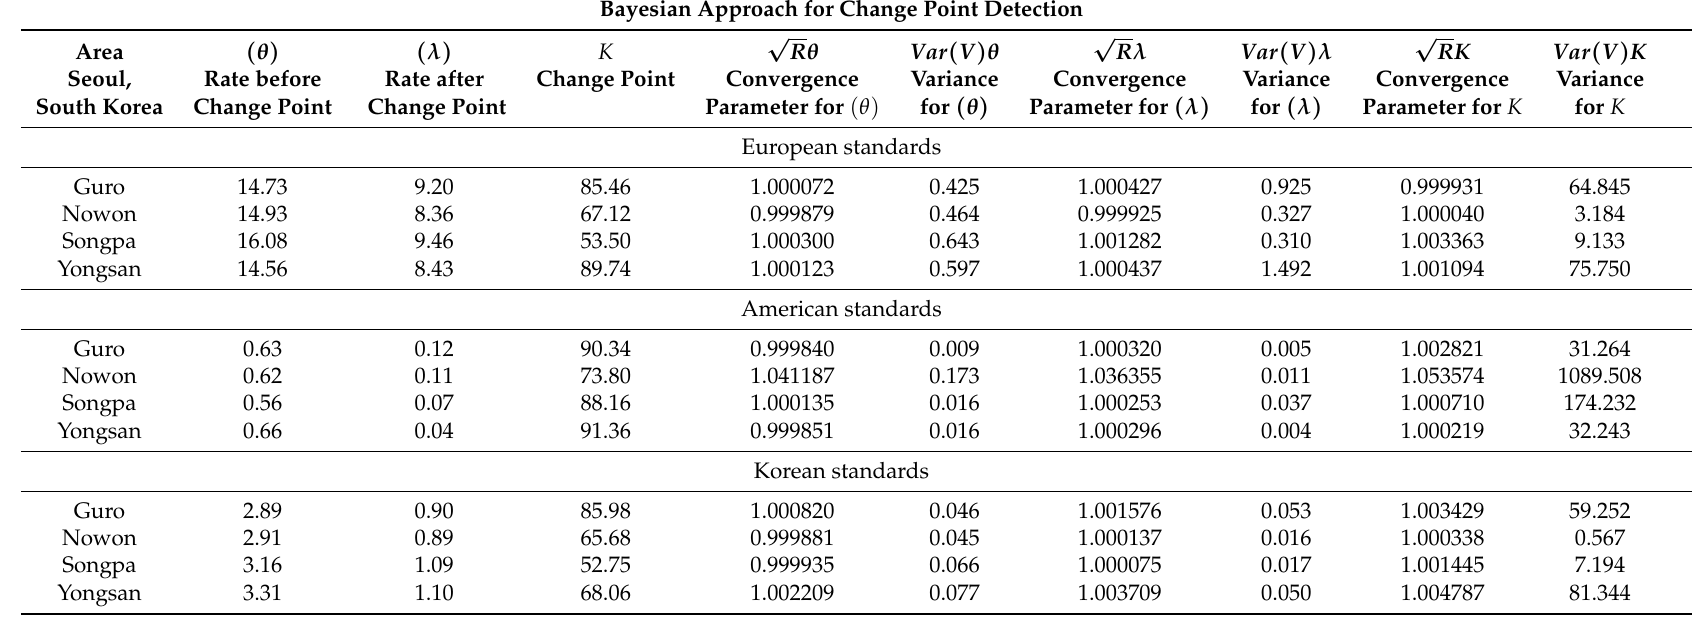
Table 13. PM 10 Change Point ( k ) for European, American and Korean